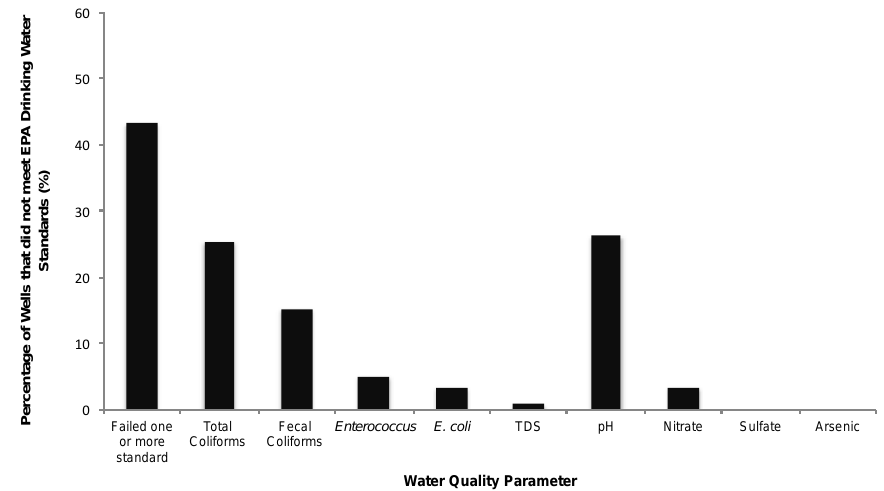
Figure 3. Percentage of tested private wells that did not meet U.S. Environmental Protection Agency (US EPA) drinking water standards. Int. J. Environ. Res. Public Health 2018 , 15 , 1686